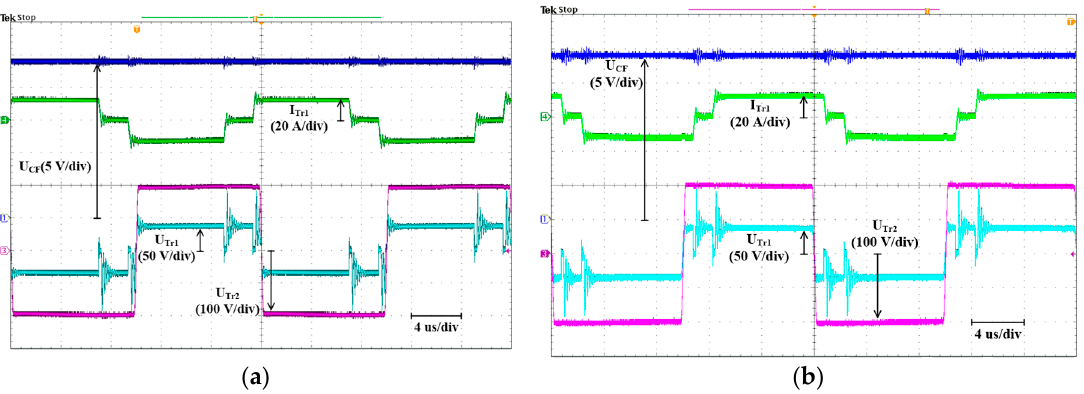
Figure 5. Operating waveforms in the PS-SMC mode: boost ( a ) and buck ( b ). U CS =24 V, P = 300 W.